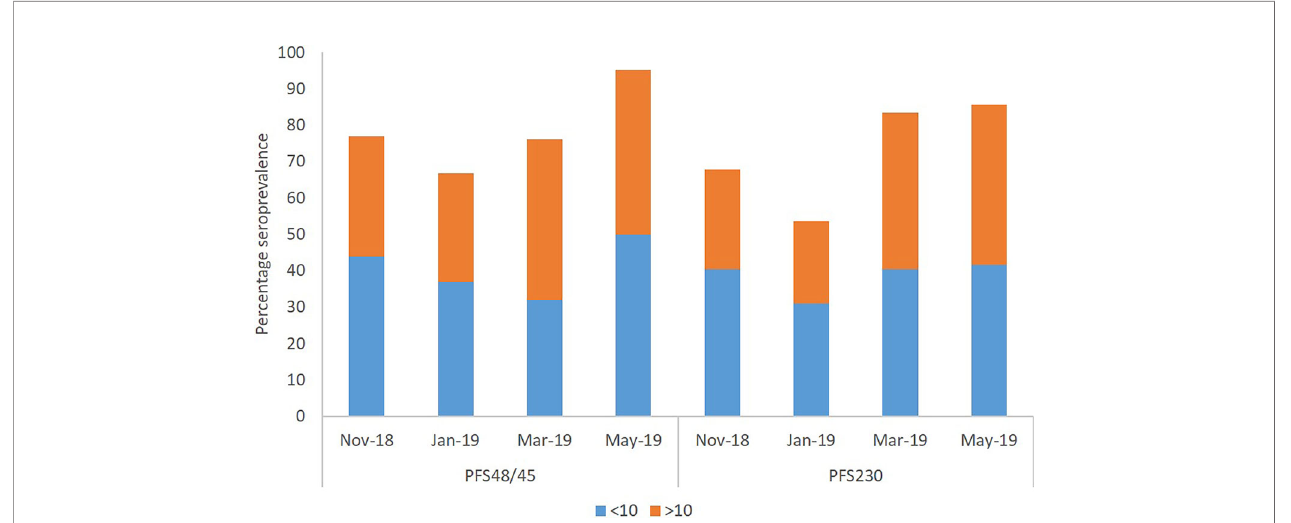
FIGURE 4 | Seroprevalence of IgG antibodies against Pfs230 and Pfs48/45. Immune responses of participants were considered seropositive when their antibody concentrations were higher than that of the average plus twice the standard deviation of the negative control sample ’ s concentration.